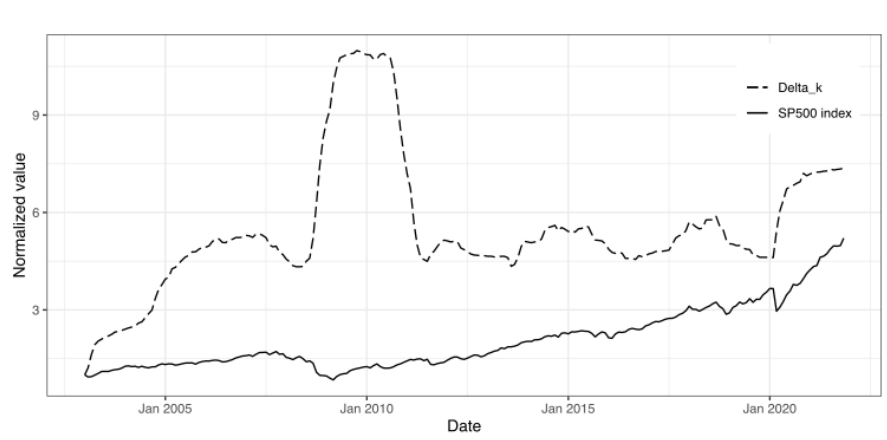
Figure 3. Gelbrich distances and S&P 100 index during 2003–2021.